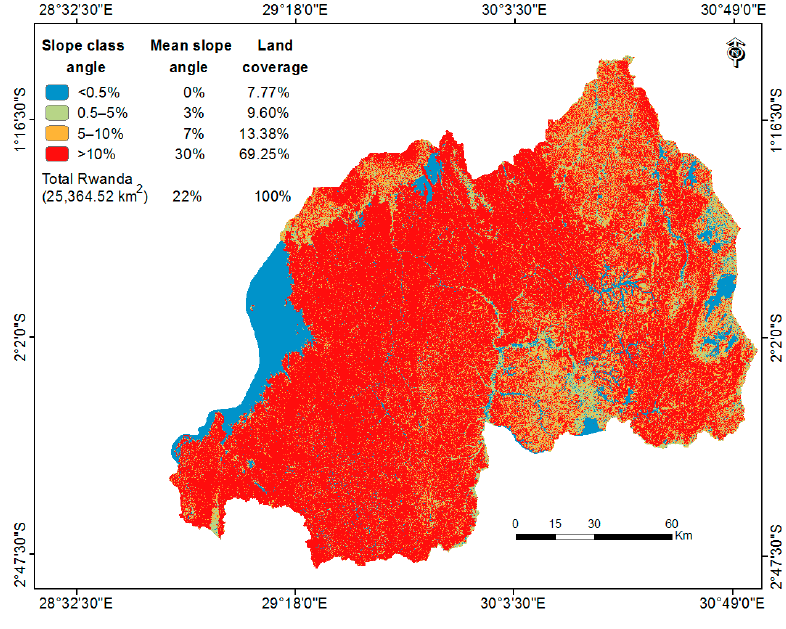
Figure 7. Slope map of Rwanda.